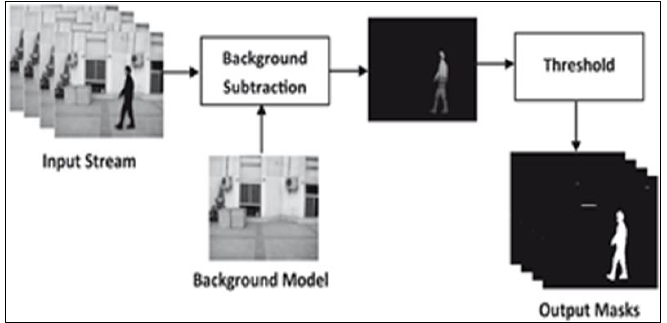
Figure 1: Back ground